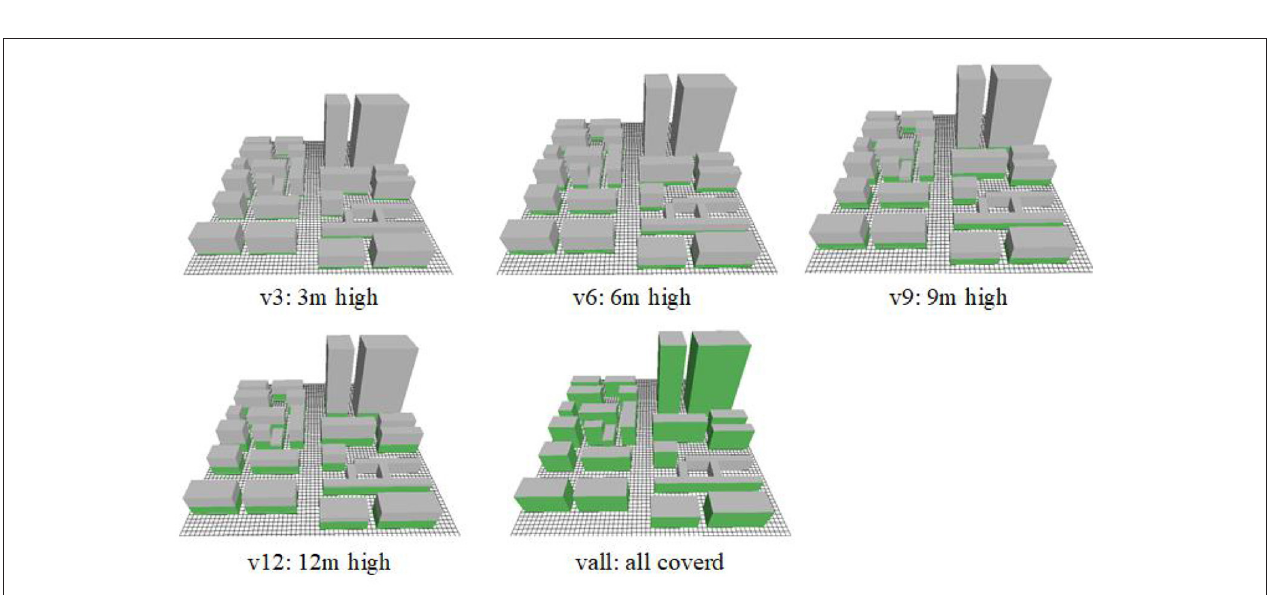
FIGURE 11 | Hourly changes of mean 1 Ta and 1 RH of different vegetation layouts in Chigang community (A) PET frequency distribution under different vegetation layout scenarios in Chigang community (B) .